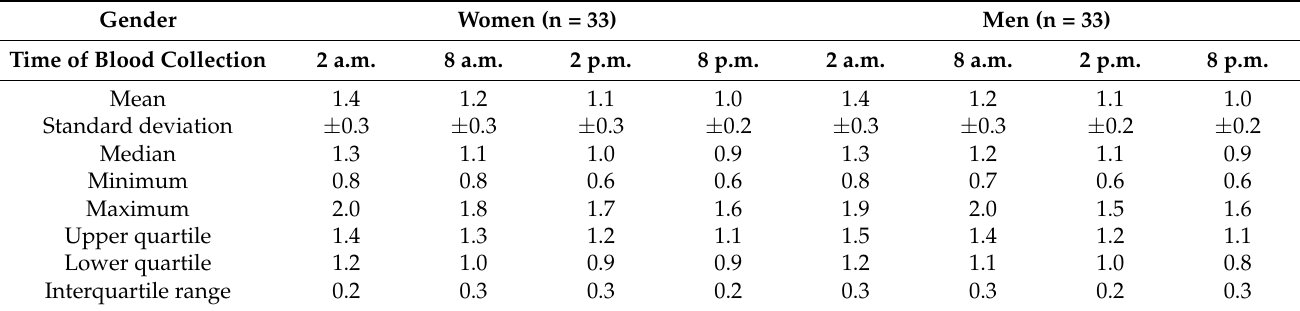
Figure 4. Average erythrocytes activity of GPx in men and women at different sampling time points. Data presented as mean ± 95% confidence interval. MANOVA-type analysis ( p = 0.96529). Table 6. Parameters describing the activity of glutathione reductase (R-GSSG) in women and men, 2.6. Analysis of the Influence of Circadian Rhythm on the Activity of Glutathione Reductase including the time of blood collection (U/g